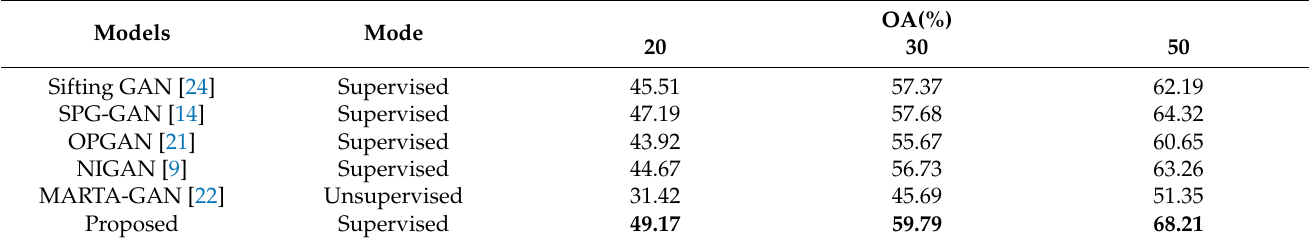
Table 4. Classification accuracy on the AID dataset.